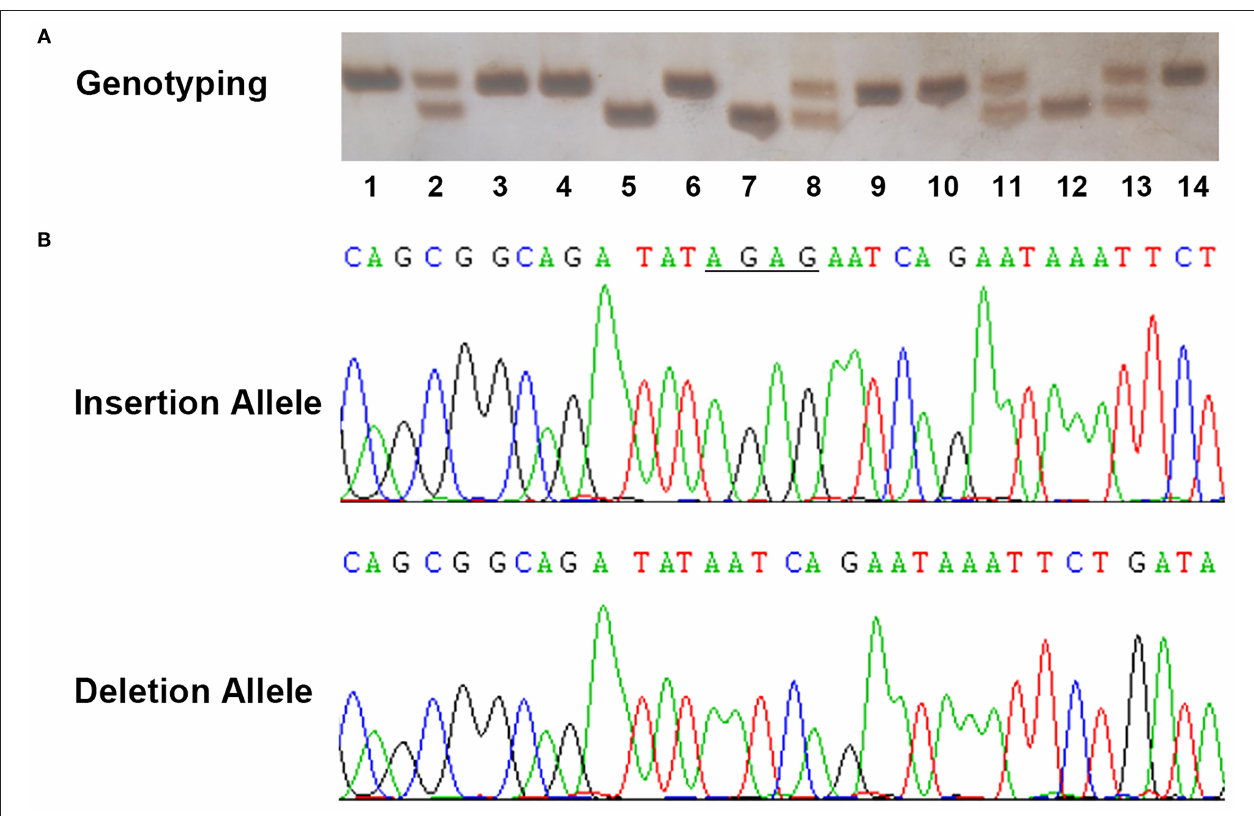
FIGURE 2 | Example output from sequencing and genotyping assays of rs72014506. (A) The genotyping outcomes by using 7% non-denaturing polyacrylamide gel electrophoresis (PAGE) and silver staining (lanes 1, 3, 4, 6, 9, 10, and 14, ins/ins genotype; lanes 2, 8, 11, and 13, ins/del genotype; lanes 5, 7, and 12, del/del genotype). (B) The sequencing results of insertion and deletion allele in template strands. The underlined bases indicate the “AGAG” insertion in coding strands.